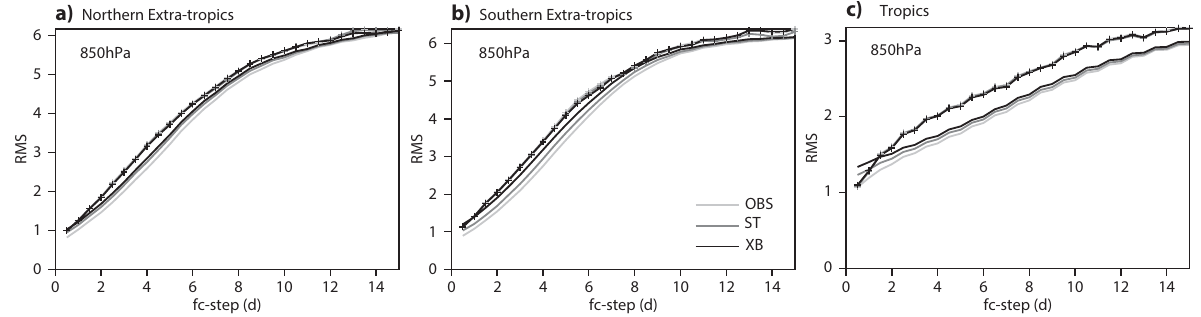
Figure 11. Averaged spread measured by the standard deviation (solid lines) and error of the ensemble mean (lines with symbols) of the EPS run with EDA-only perturbations generated from OBS-EDA (light grey), ST-EDA (dark grey) and XB-EDA (black). Results refer to the zonal wind component at 850hPa over the (a) Northern Hemisphere (20–80 ◦ N), (b) Southern Hemisphere (20–80 ◦ S) and (c) tropics (20 ◦ S–20 ◦ N). The average has been computed considering 18 cases, each with 51-member EPS forecast with initial condition from 12 to 14 November 2008, every other day (12:00UTC